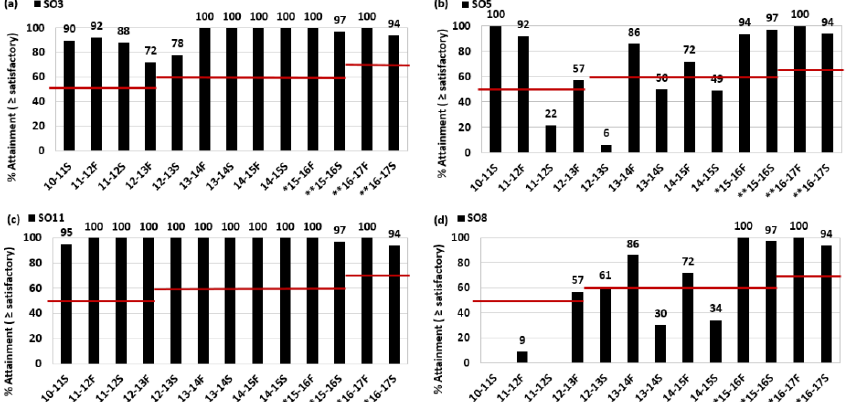
Overall assessment of attainment level (at/above “satisfactory”) of SO3 (a), SO5 (b), SO11 (c), and SO8 (d) by the GDP in 13 consecutive review cycles between 2010–11 and 2016–17 Spring terms. Horizontal lines show the set thresholds. See Table 1 for the